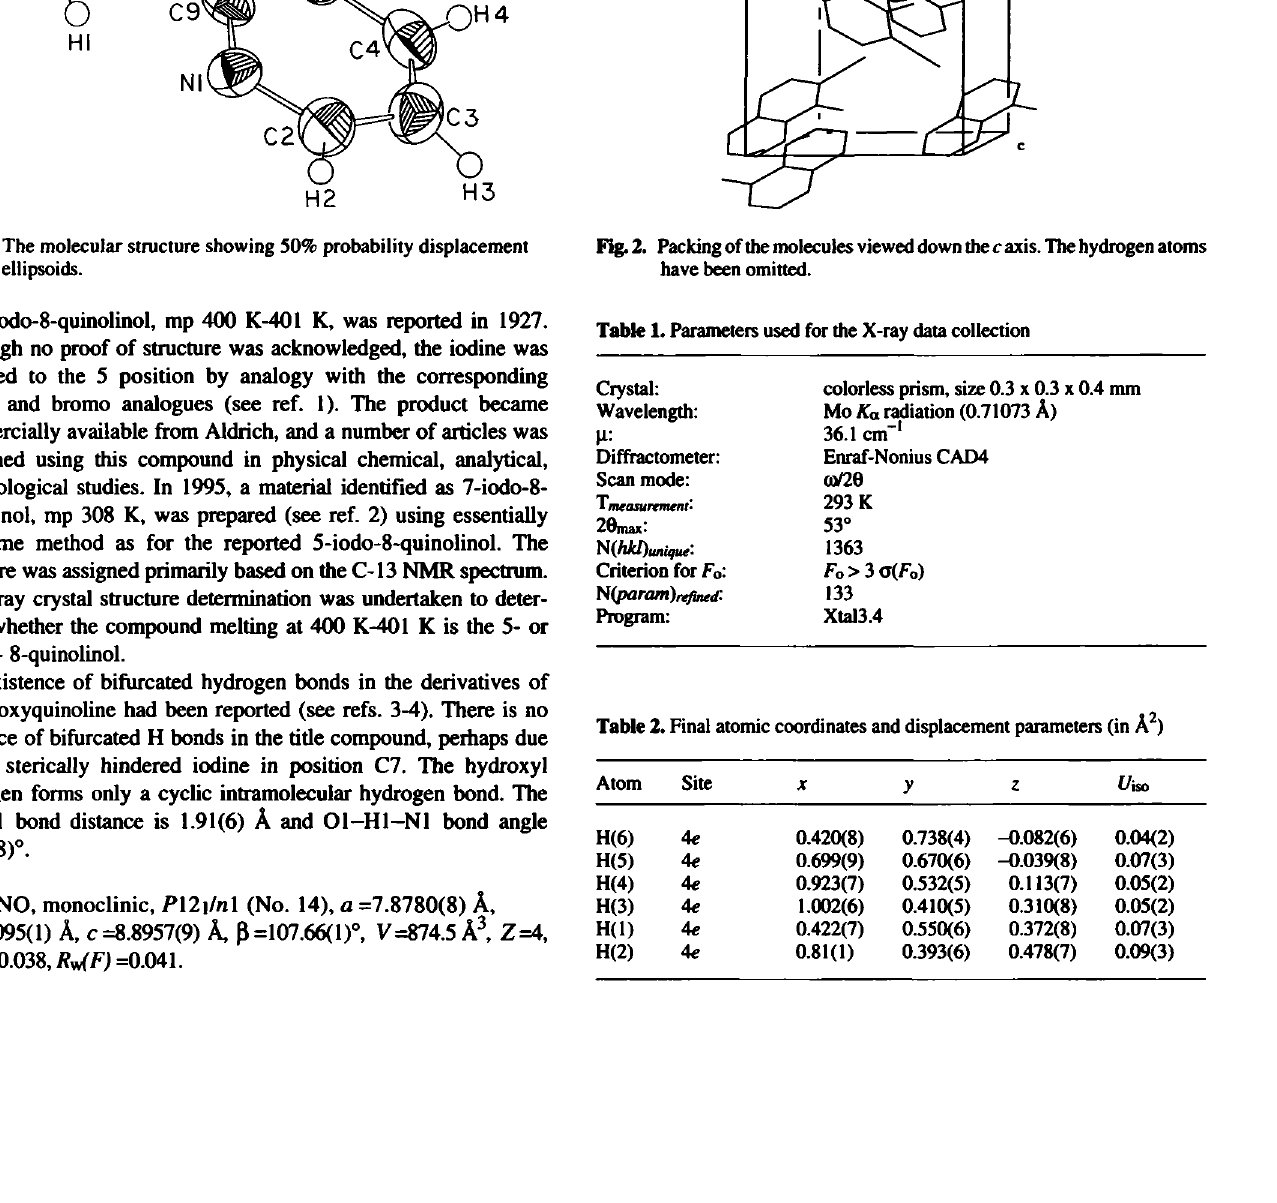
Fig. 1. The molecular structure showing 50% probability displacement ellipsoids.